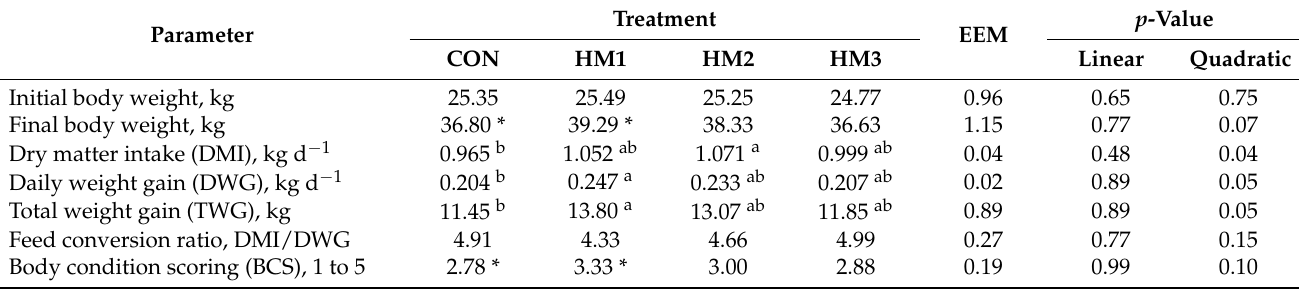
Table 1. Growth performance of lambs supplemented with a polyherbal mixture 1 during the final fattening period.